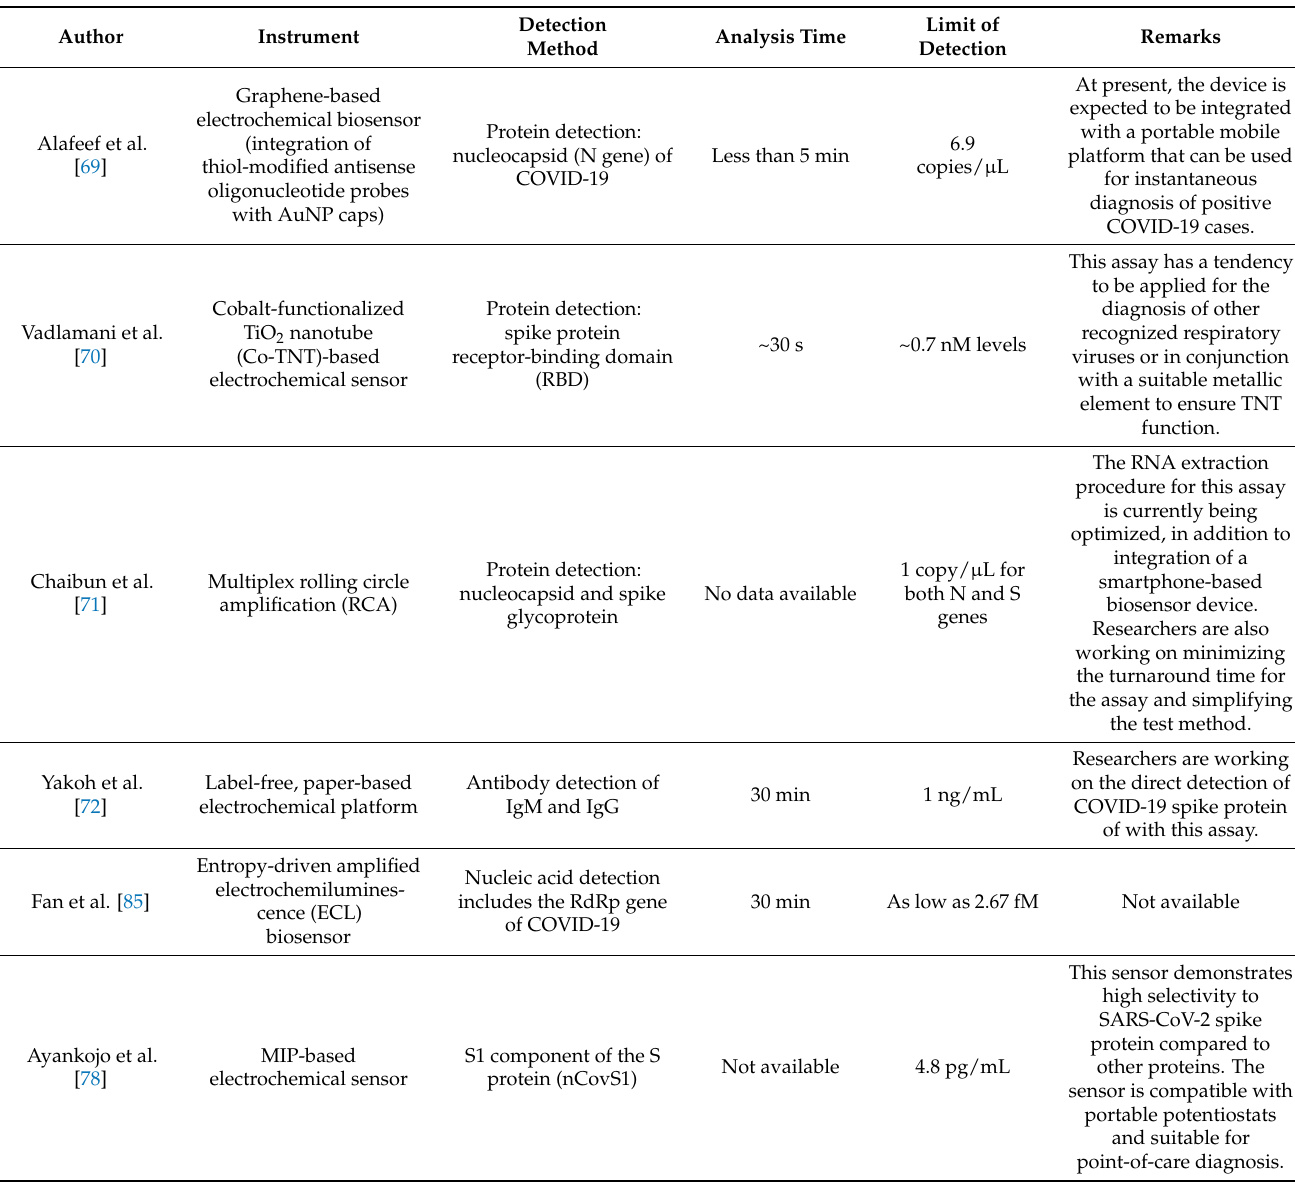
Table 2. Summary of electrochemical biosensor that are used for the detection of COVID-19 using protein, antibodies, nucleic acid and molecular imprinted